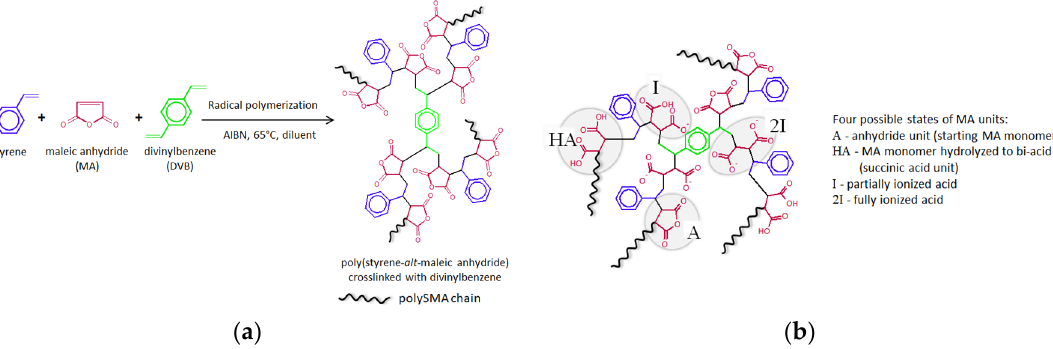
Figure 1. ( a ) Simplified reaction scheme of the synthesis and structure of polySMA hydrogels; ( b ) chemical structure of hydrolyzed polySMA hydrogel after swelling in PBS solution (pH